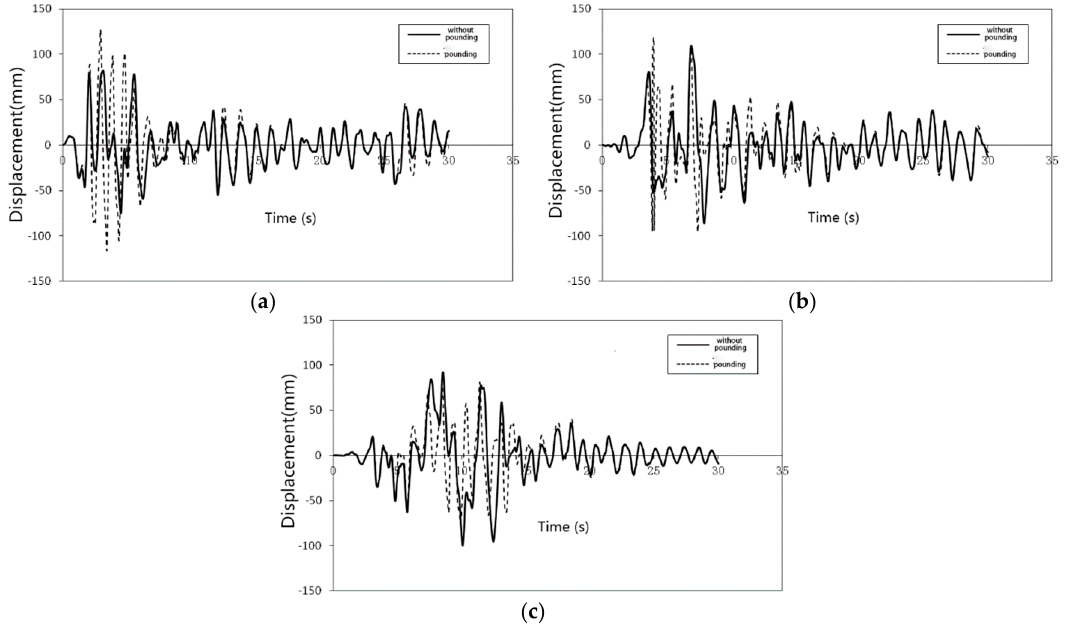
Figure 20. Structural displacement under different earthquakes (model A). ( a ) El Centro earthquake; ( b ) Taft earthquake; and, ( c ) Artificial excitation.